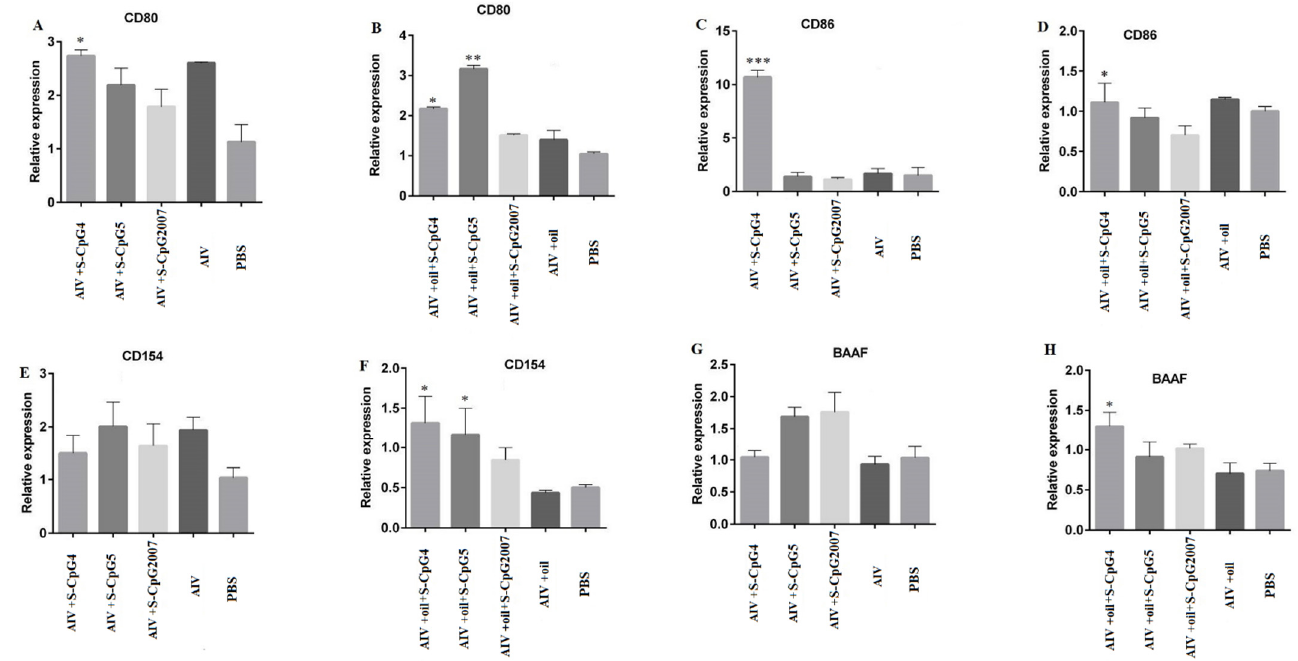
Figure 8. Expression levels of CD80, CD86, CD154, and BAAF on splenic lymphocytes. The expressions of CD80 ( A ), CD86 ( C ), CD154 ( E ) and BAAF ( G ) of splenic lymphocytes from immunized with S-CpG4, 5 and S-CpG2007 and AIV antigen were detected with qPCR, and expressions of CD80 ( B ), CD86 ( D ), CD154 ( F ) and BAAF ( H ) from immunized with S-CpG4, 5 and S-CpG2007 and AIV antigen with oil adjuvant were measured with qPCR. All data were presented as mean ± SD. * p < 0.05, ** p < 0.01, and *** p < 0.001.